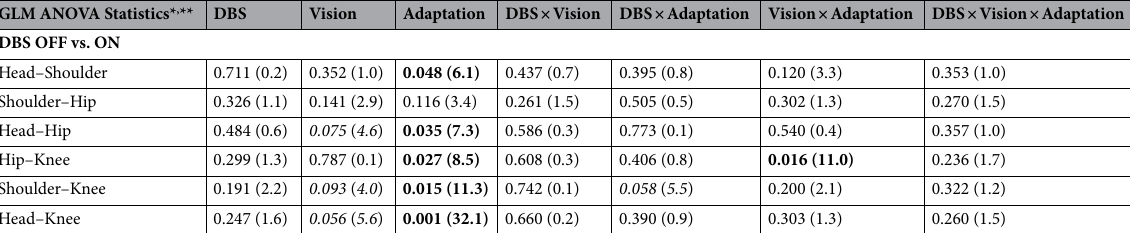
Table 1. DBS, vision and adaptation effects on the body movement pattern. *Repeated measures GLM ANOVA of movement patterns with main factors “DBS”, “Vision” and “Adaptation” and their factor interactions. The F-values are presented within the parenthesis. **Significant differences are marked with bold numbers and trends (p < 0.1) are marked with italics